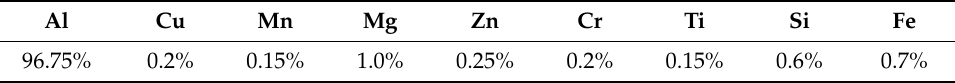
Table 1. Chemical composition of the 6061 alloy